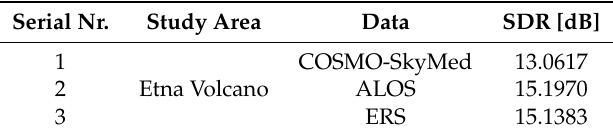
Table 4. SDR of retrieved SAR interferometric